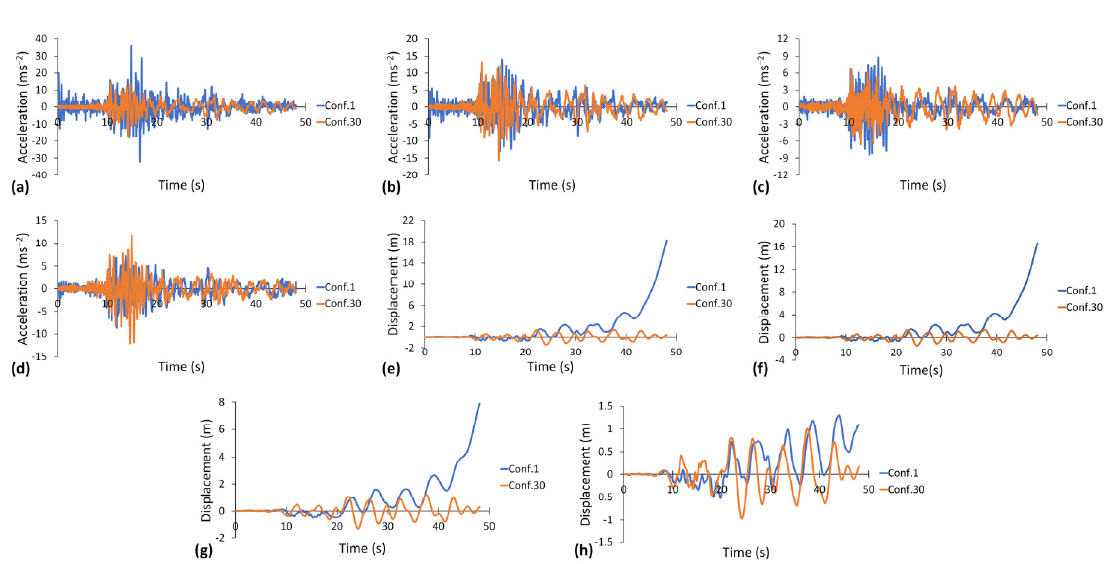
Figure 15. Structural response time histories under Landers earthquake: ( a ) acceleration at the top of the structure, ( b ) acceleration at the top of the fourth substructure, ( c ) acceleration at the top of the third substructure, ( d ) acceleration at the top of the second substructure, ( e ) displacement at the top of the structure, ( f ) displacement at the top of the fourth substructure, and ( g ) displacement at the top of the third substructure and ( h ) displacement at the top of the second substructure.